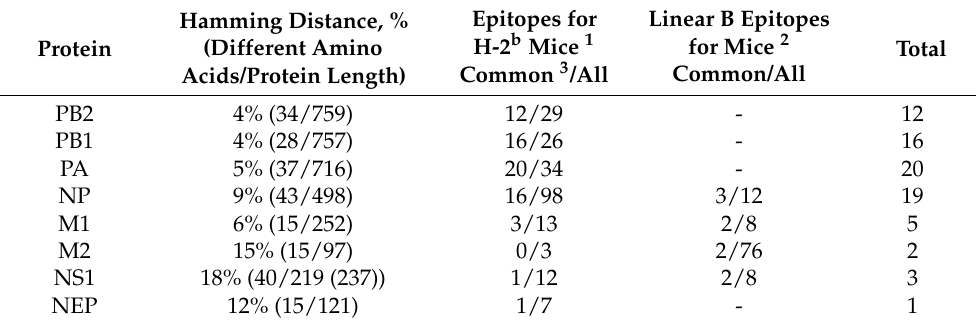
Table 5. Difference of the internal proteins of the A/Len/17 and A/California/07/2009 viruses and experimentally established epitopes for mice according to the Immune Epitope Database